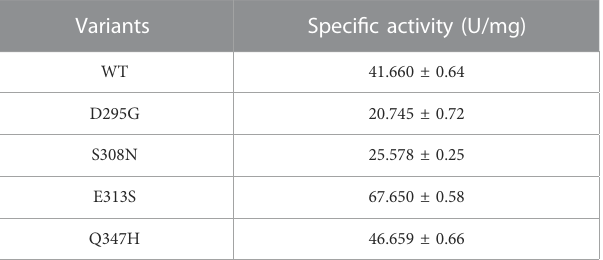
TABLE 3 Determination of speci fi c activity of LpGAD and its variants.